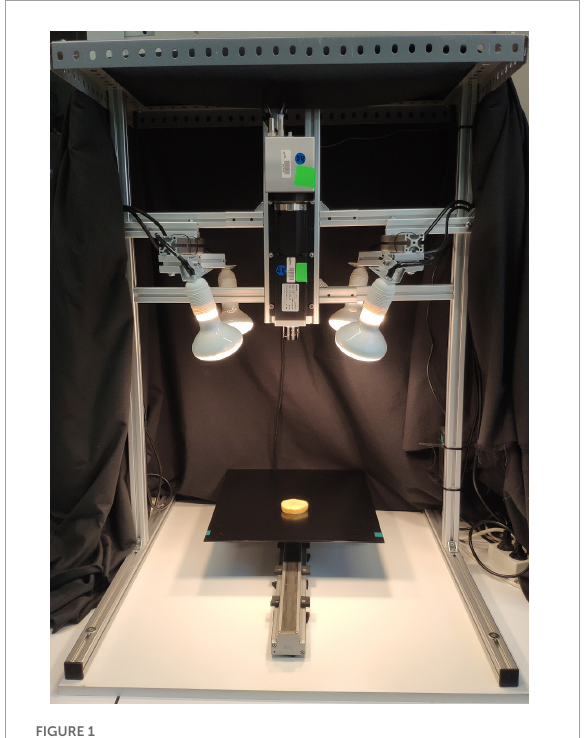
FIGURE1 The imaging system used in this study with a sample of a potato slice placed on the